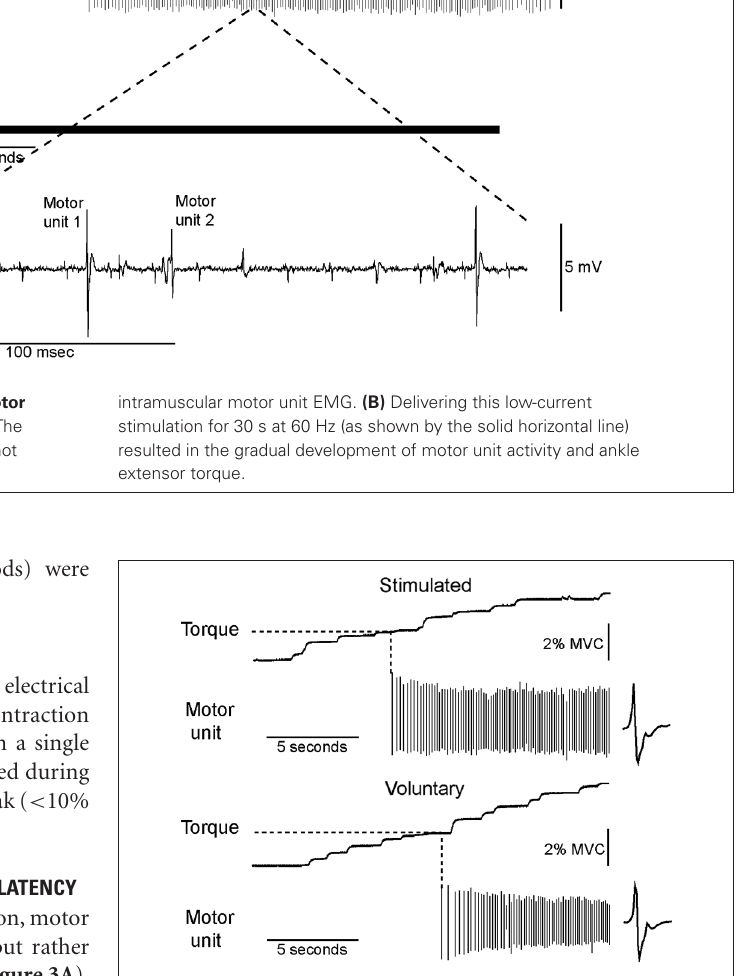
FIGURE 2 | All motor units recruited during low-current stimulation were also recruited during weak voluntary contractions . The torque level at which a motor unit first fired was measured for both electrically stimulated and voluntary contractions, as illustrated for a motor unit recorded from a single